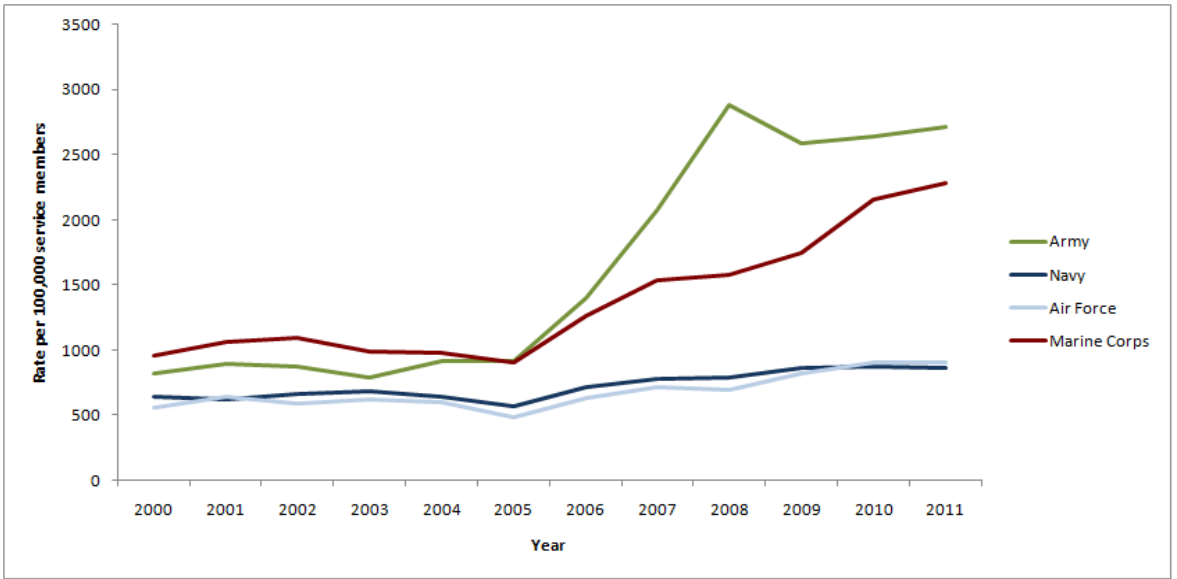
Figure 3. Estimated Overall Annual incidence Rates of TBI among Active-Duty